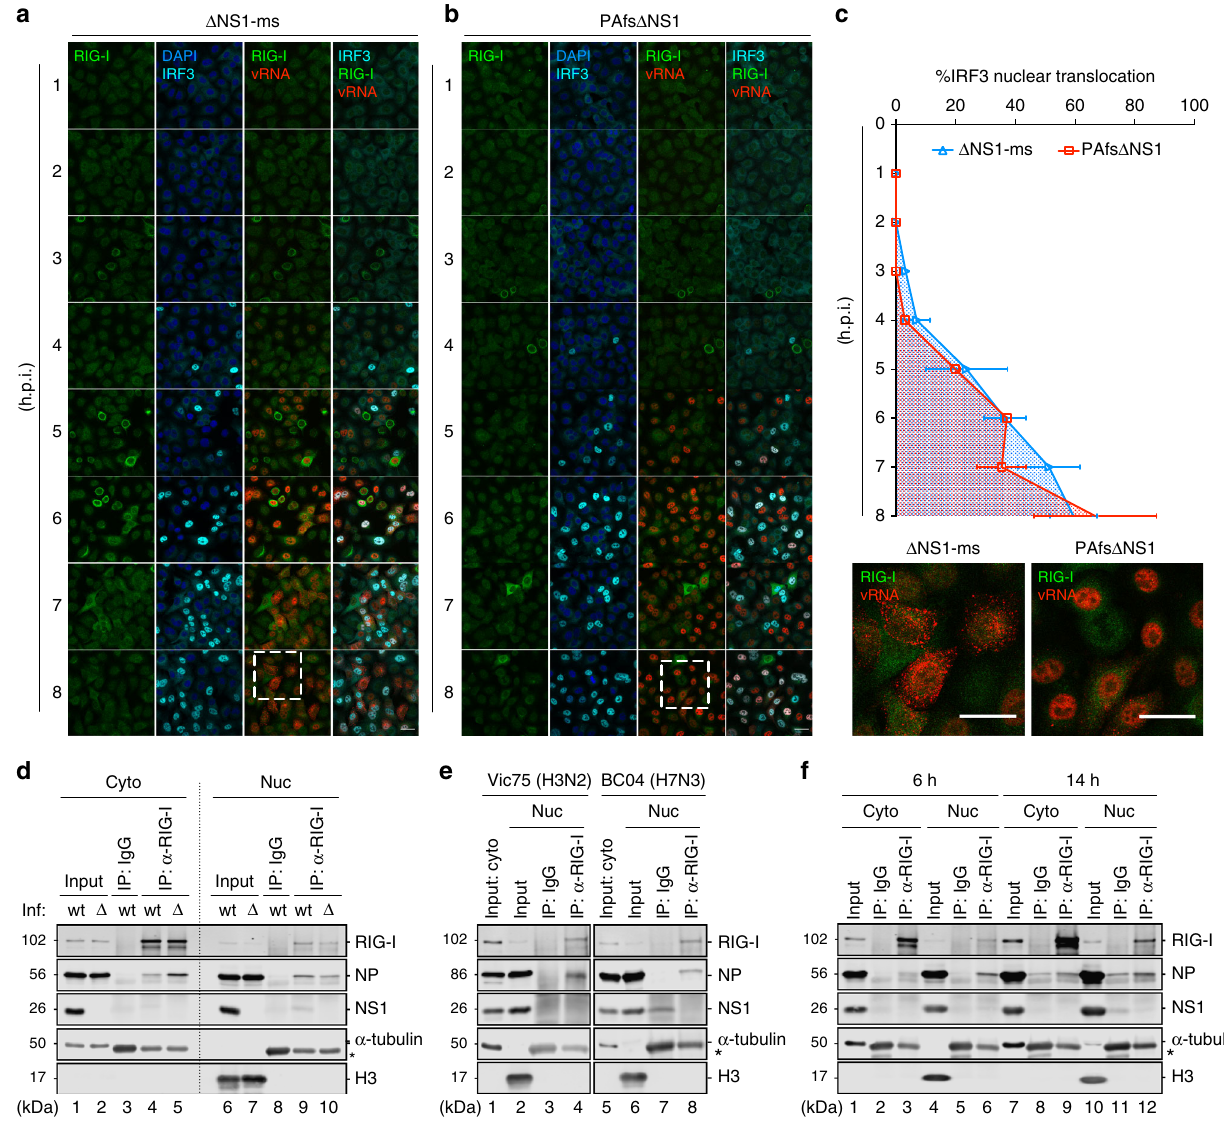
Fig. 2 Nuclear-resident RIG-I constantly binds IAV vRNPs in the nucleus. a , b A549 cells were infected with Δ NS1-ms or PAfs Δ NS1 virus at an MOI of 10. At indicated time points post-infection, cells were subjected to immuno fl uorescence for RIG-I (green) and IRF3 (cyan), and FISH for vRNA of the M segment (red). Nuclei were stained with DAPI (blue). The insets highlight the distinct vRNA distribution of the two mutant viruses. Scale bar = 25 μ m. c Percentage of A549 cells with IRF3 nuclear translocation upon Δ NS1-ms and PAfs Δ NS1 infections was quanti fi ed from at least three random fi elds with ~100 cells for each time point after infection. d A549 cells were infected with WT PR8 or Δ NS1-ms ( Δ ) at an MOI of 5. At 8 h.p.i, cells were subjected to cellular fractionation and both cytoplasmic (Cyto) and nuclear (Nuc) fractions were immunoprecipitated (IP) with the RIG-I antibody or an IgG isotype control. The immunoprecipitates were analyzed by immunoblotting for RIG-I, NP, and NS1. α -tubulin and histone H3 served as the markers for the cytoplasmic and nuclear fractions, respectively. The heavy chains of IP antibodies are indicated by an asterisk (*). e Co-immunoprecipitation in the nuclear fractions of A549 cells infected with A/Victoria/3/75 (H3N2) or A/chicken/British Columbia/CN-6/2004 (H7N3) was performed as in ( d ). f A549 cells were infected with WT PR8 (MOI = 2) for 6 or 14 h. Cells were subjected to cellular fractionation and co-immunoprecipitation in both the cytoplasmic and nuclear fractions was performed as in ( d